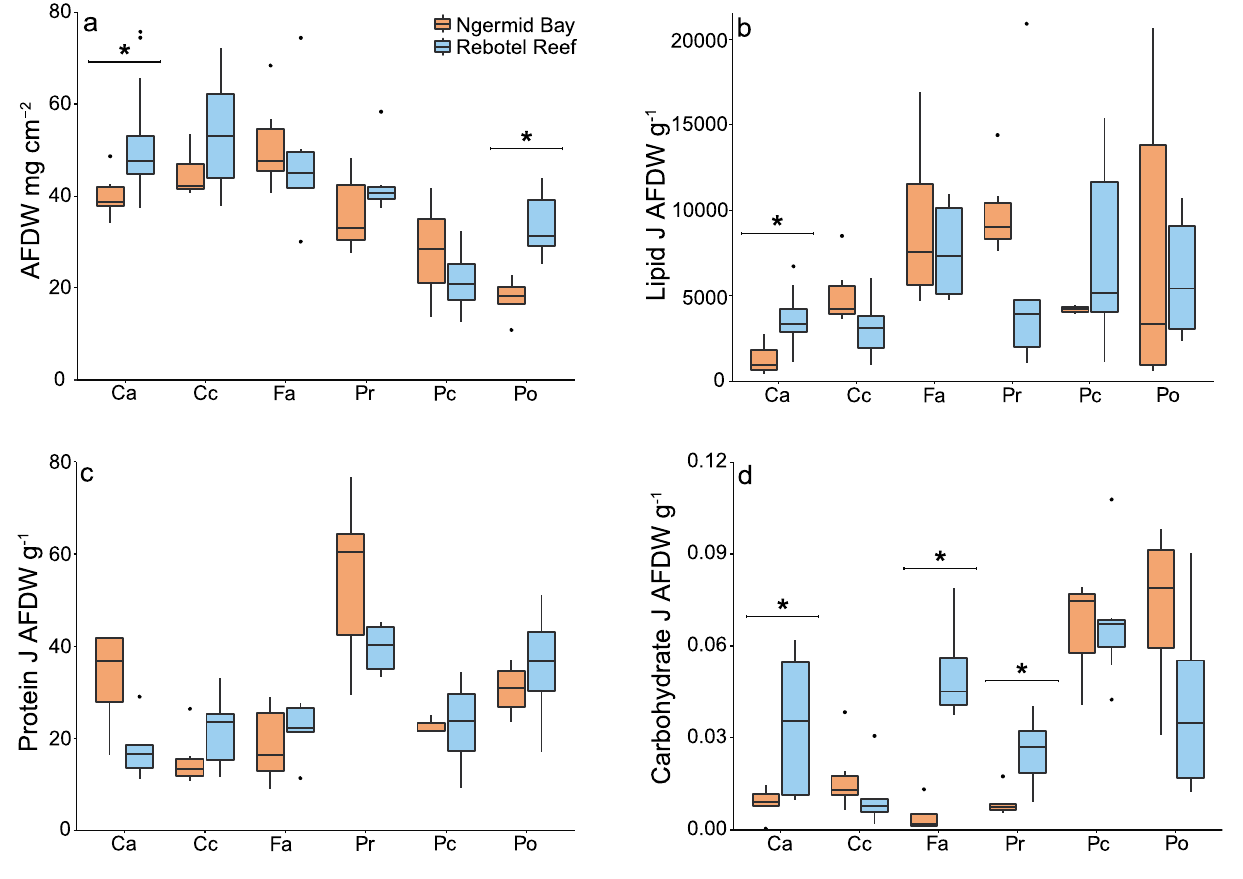
Figure 2. Coral biomass and energy reserves from six coral species from nearshore (Ngermid Bay; orange) and offshore sites (Rebotel Reef; blue). ( a ) Total biomass in ash-free dry weight normalized to coral surface area from six coral species ( b ) total lipid, ( c ) soluble protein, and ( d ) carbohydrates. Abbreviations for coral species are as follows: Ca, Coelastrea aspera ; Cc, Cyphastrea chalcidicum ; Fa, Favites abdita ; Pr, Pachyseries rugosa ; Pc, Porites cylindrica , and Po, Porites rus . Tukey boxplots depict median, first and third quartile, and whiskers extend no more than 1.5 × the interquartile range, with outliers plotted individually. Significant intraspecific differences are denoted with a bracket and *. See Table 2 for sample sizes.